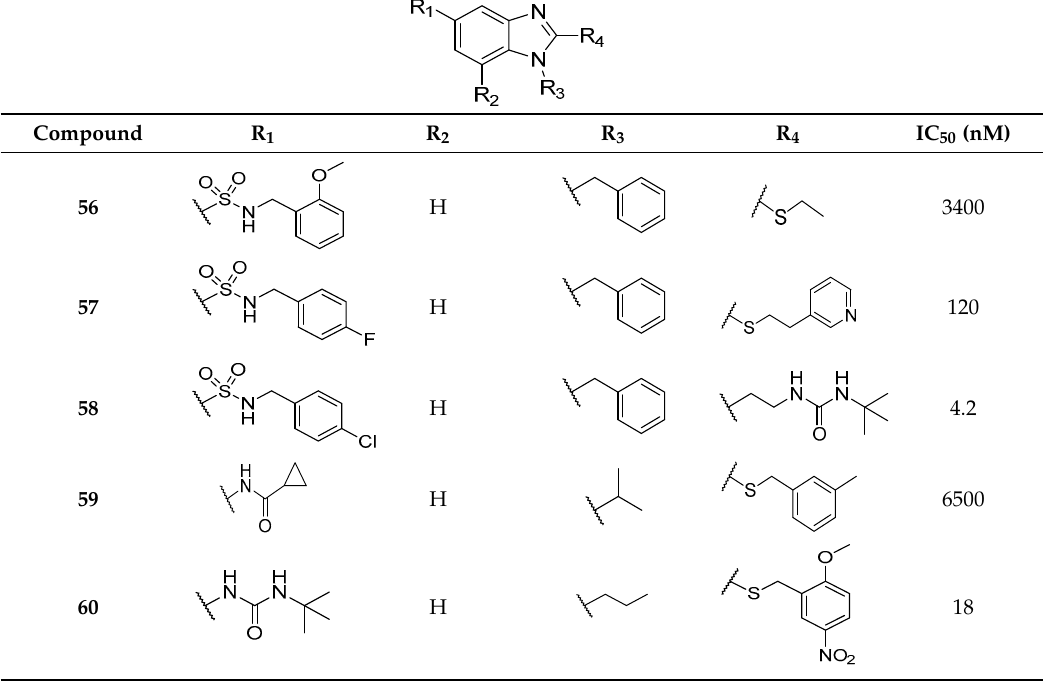
Table 10. Benzimidazole derivatives and their affinity at human GnRH-R.